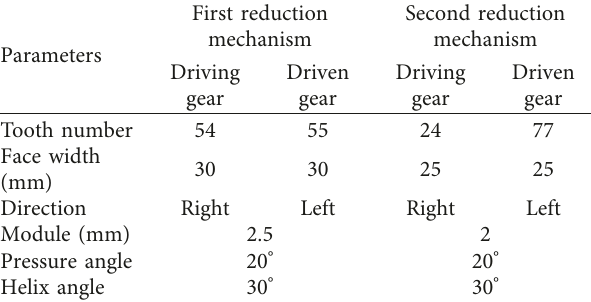
Table 2: Gear parameters of the first and second reduction mechanisms.